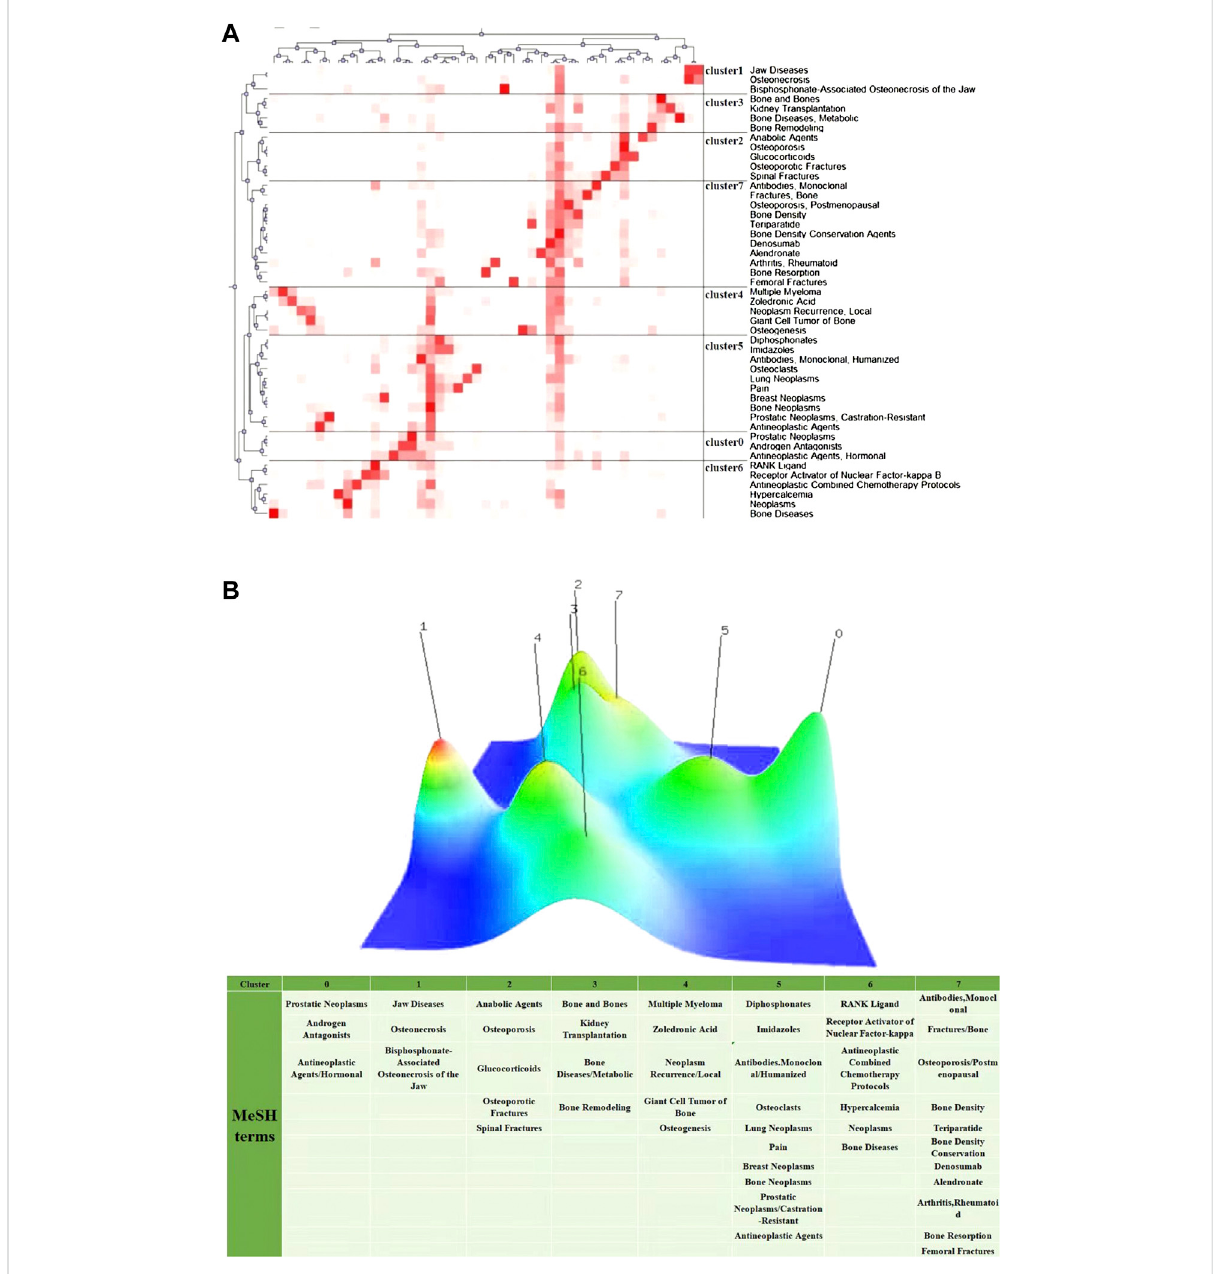
FIGURE 7 Visualizationofbiclusteringanalysis. (A) Matrixvisualizationofbiclusteringhigh-frequencymajorMeSHtermsindenosumabfrom2011to2021. (B) Mountain visualization of biclustering high-frequency major MeSH terms in denosumab from 2011 to